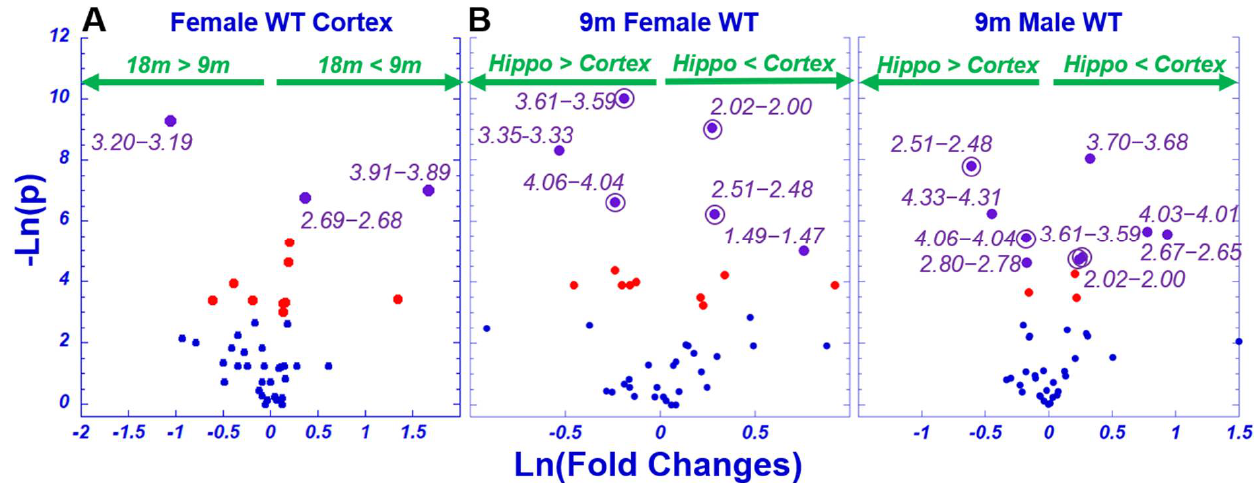
Figure 3. Differentiations of WT Animal Age and Brain Region with Individual Spectral Regions According to p -values and Fold Changes. ( A ) Age differentiations for female cortex; ( B ) cortex and hippocampus differentiations for female and male animals. All the analyzed 42 spectral regions are presented in plots, in which blue indicates insignificant points, red indicates significant original p -values, and purple indicates significant regions after FDR corrections. Regions labeled in purple with circles indicate common FDR significant regions seen in both males and females. Hippo, hippocampus; m, months.